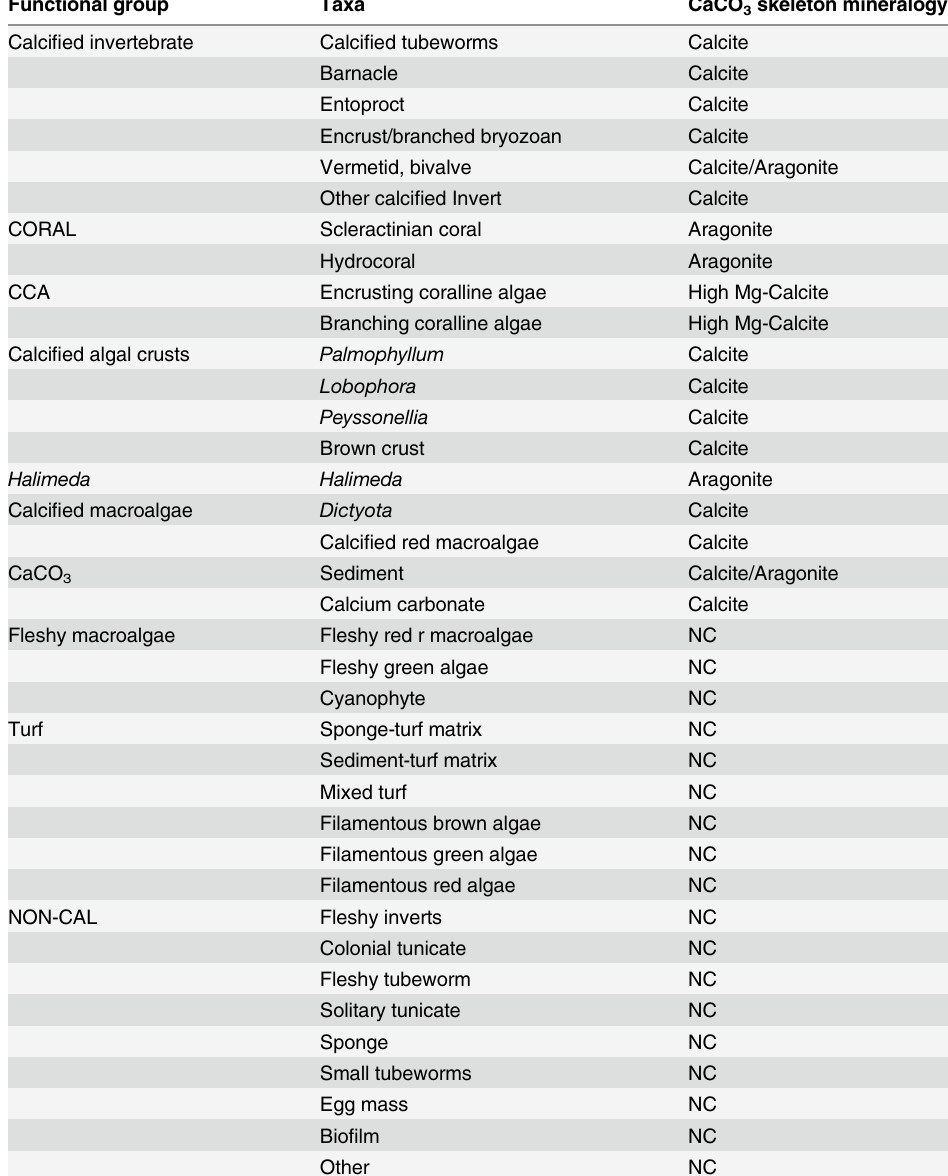
Table 2. Functional group classification and mineralogical exoskeletal composition of the taxa com- prising the benthic communities at study sites and recruited to the CAU plates. NC: non-calcifying. Functional